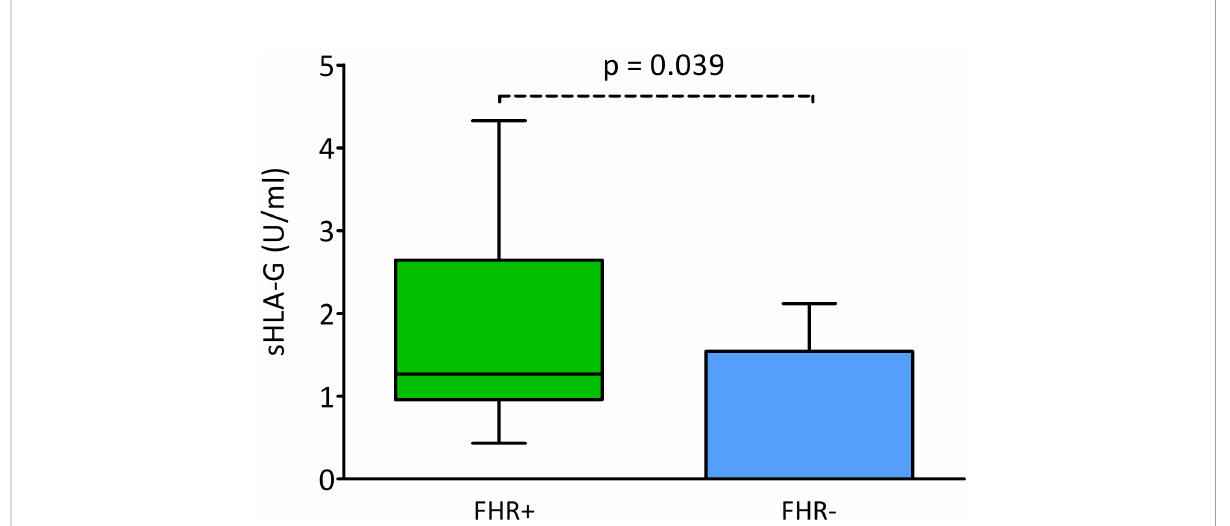
FIGURE 6 Effect of sHLA-G secretion by embryos on the presence of pregnancy markers. Green box represents the level of sHLA-G measured in embryo media resulting in FHR-positivity; blue box – FHR-negativity. Boxes are drawn from the fi rst quartile (25 th percentile) to the third quartile (75 th percentile). Black lines in boxes are medians. Whiskers represent 10-90 percentiles. P-values are calculated by Mann-Whitney test. FHR – fetal heart